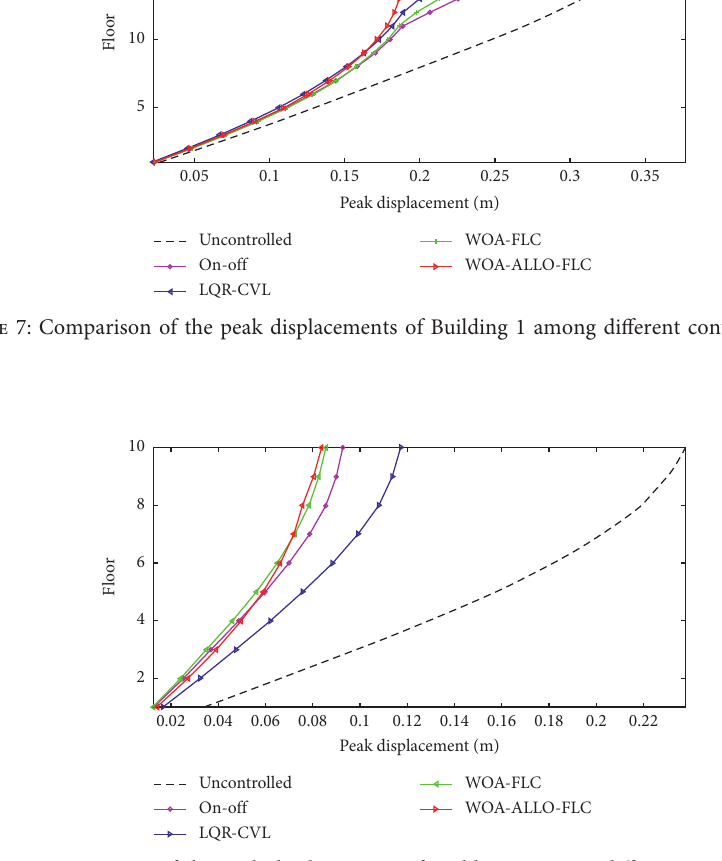
Figure 8: Comparison of the peak displacements of Building 2 among different control